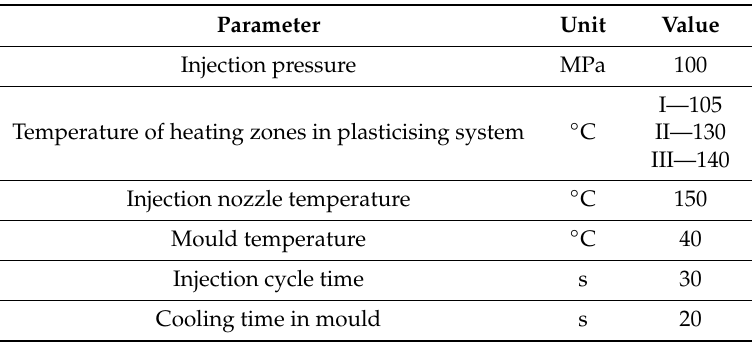
Table 1. Technological parameters of the injection